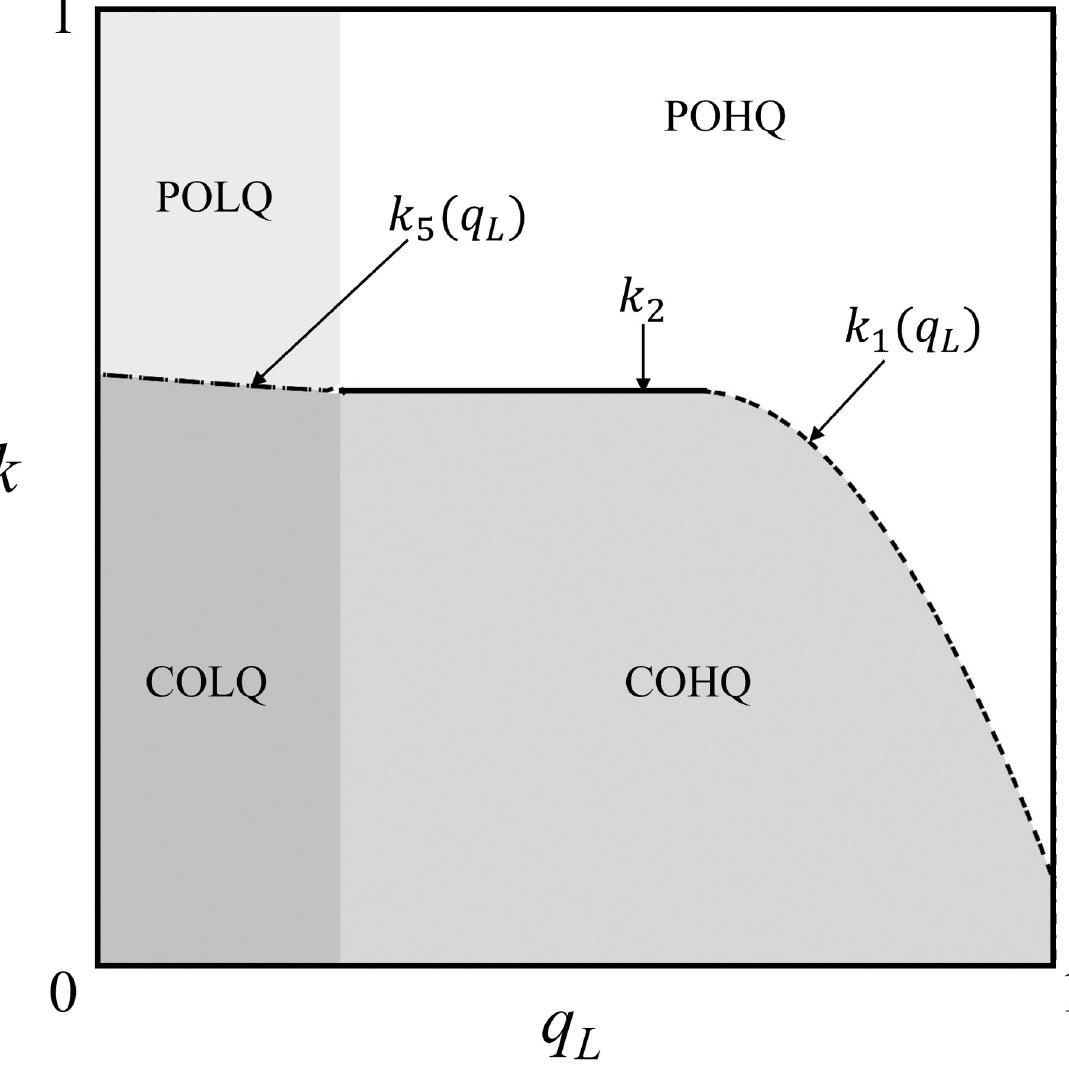
Fig 3. The influence of k and q on the maximal profit scenario of M 1 ( a = 1; α = 0.5; m = 0.02; c = 0.8). L